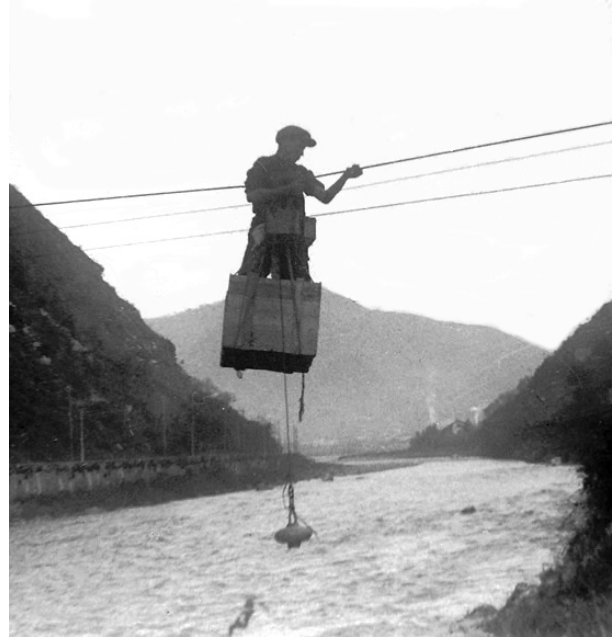
Figure 2. Stream flow measurements at gauge station Borgo a Moz- zano (43 ◦ 59 (cid:48) 30.73 (cid:48)(cid:48) N; 10 ◦ 33 (cid:48) 10.04 (cid:48)(cid:48) E) in the River Serchio (Italy), probably taken in the 1920s or 1930s. The observer is placed in a box suspended on cable that moved along the cross section from which an old device is managed to measure the stream flow veloc- ity (photo courtesy of Regione Toscana - Genio Civile di Bacino Toscana Nord e Servizio Idrologico